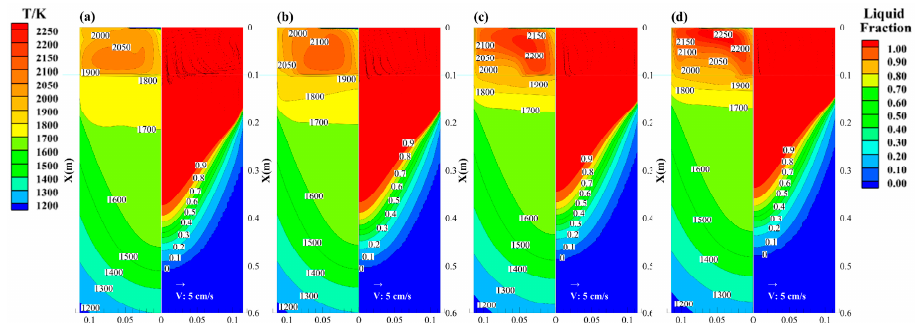
Figure A1. Temperature distribution (left of each figure) and liquid metal volume fraction distribution (right of each figure) as varying filling ratios at end of steady-state: ( a ) 0.16, ( b ) 0.23, ( c ) 0.33 and ( d ) 0.43.